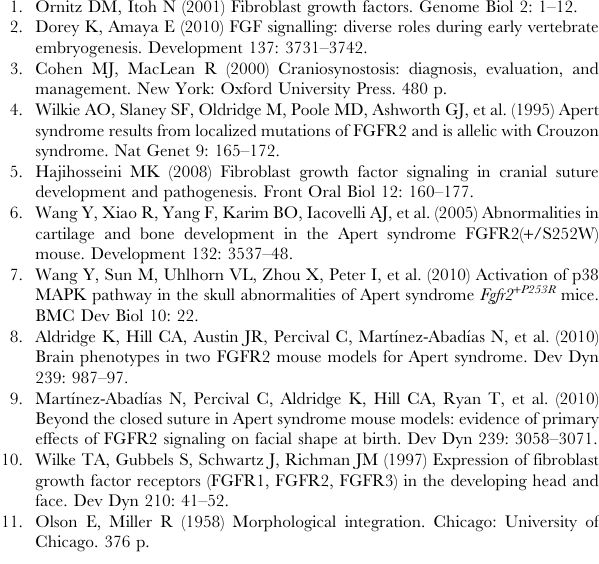
subsets of landmarks (K =8). Arrows indicate the RV coefficient for the actual hypothesis tested (modularity of face and